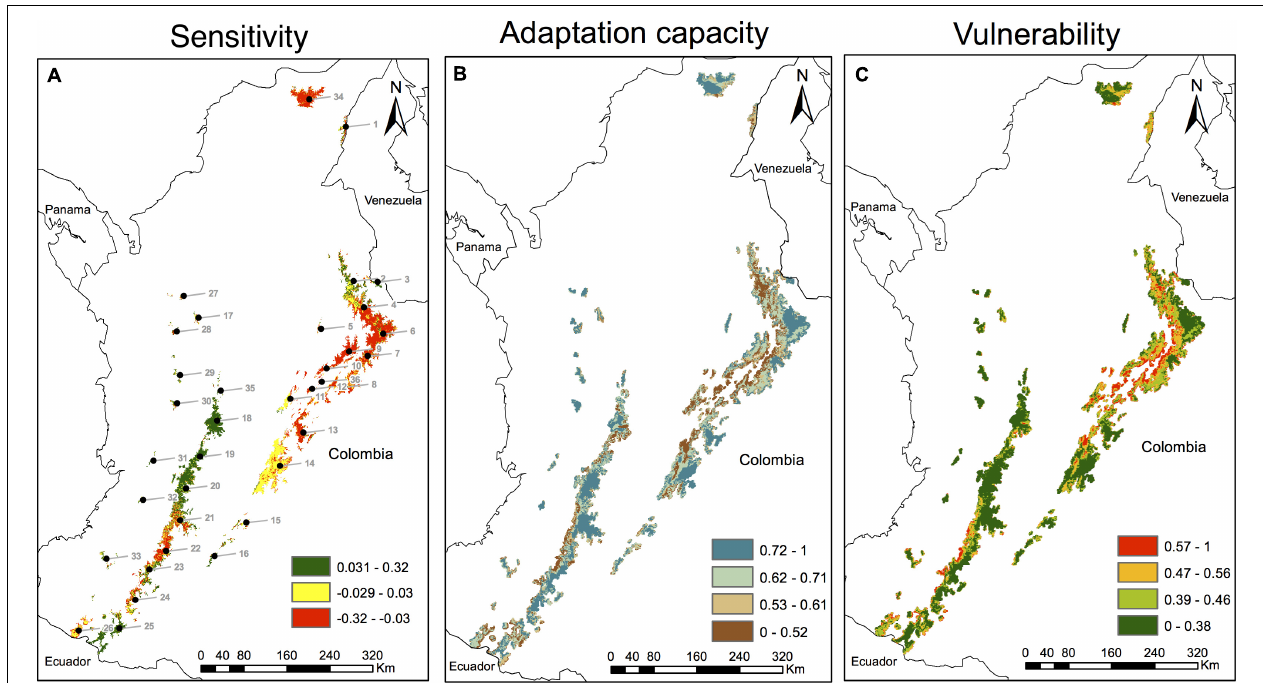
FIGURE 4 | Climate sensitivity, adaptive capacity and climate vulnerability in the Espeletia complex across 36 Páramo sky island complexes in the Colombian Andes. Climate sensitivity (A) is already depicted in Figure 2C and is brought here for comparative purposes. Adaptive capacity (B) was computed as the scaled additive effects of all six variables shown in Figure 3 . Climate vulnerability (C) was calculated as the complement value of the additive contributions of the sensitivity and the adaptive capacity indices, scaled from 0 to 1. Negative values in the sensitivity index (A) suggest range losses in the presence probabilities of Espeletia due to climate change. Low values in the adaptive capacity score (B) indicate a major role of limiting factors of the plastic response (i.e., agriculture, mining, and population density, Figures 3D–F ) as compared to enhancing drivers of the biodiversity’s adaptive potential (i.e., diversity, protected areas, and forest area around the